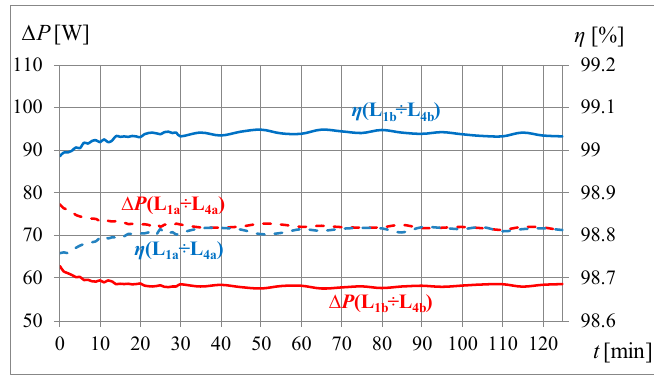
Figure 14. Power losses ( Δ P) and efficiency ( η ) versus time of steady-state operating, obtained at f s = 125 kHz, P n = 6 kW, D = 0.45 with use of different types of input inductors: L 1a – L 4a (dotted lines) or L 1b – L 4b (solid lines).